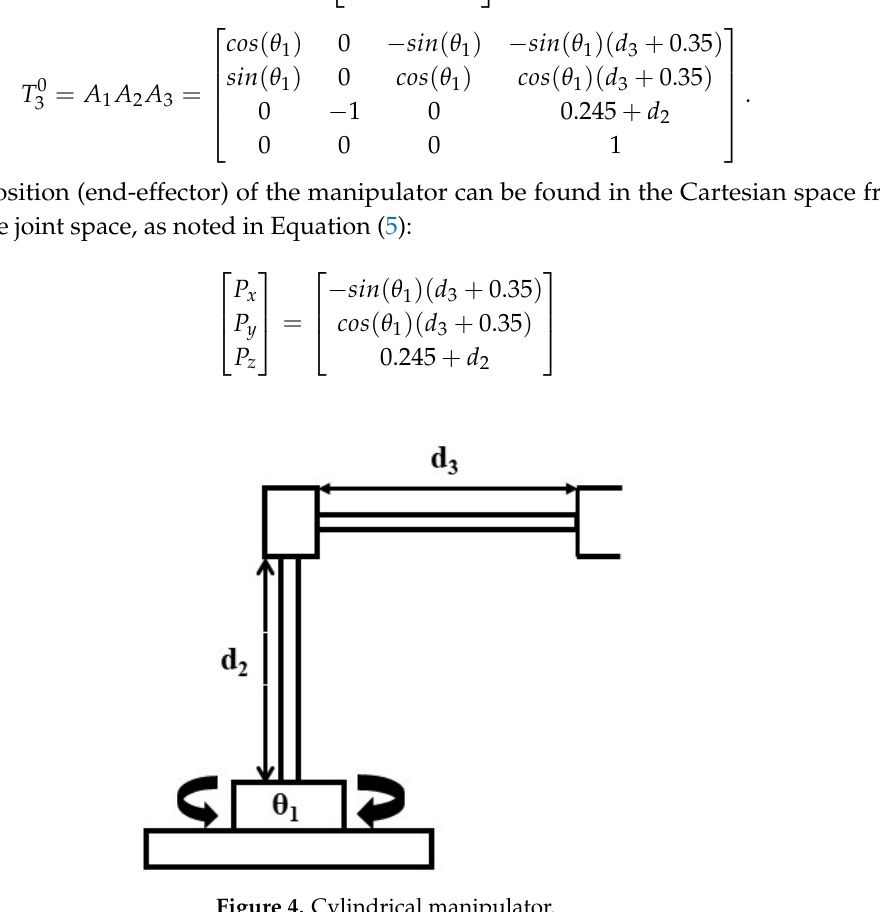
Figure 4. Cylindrical